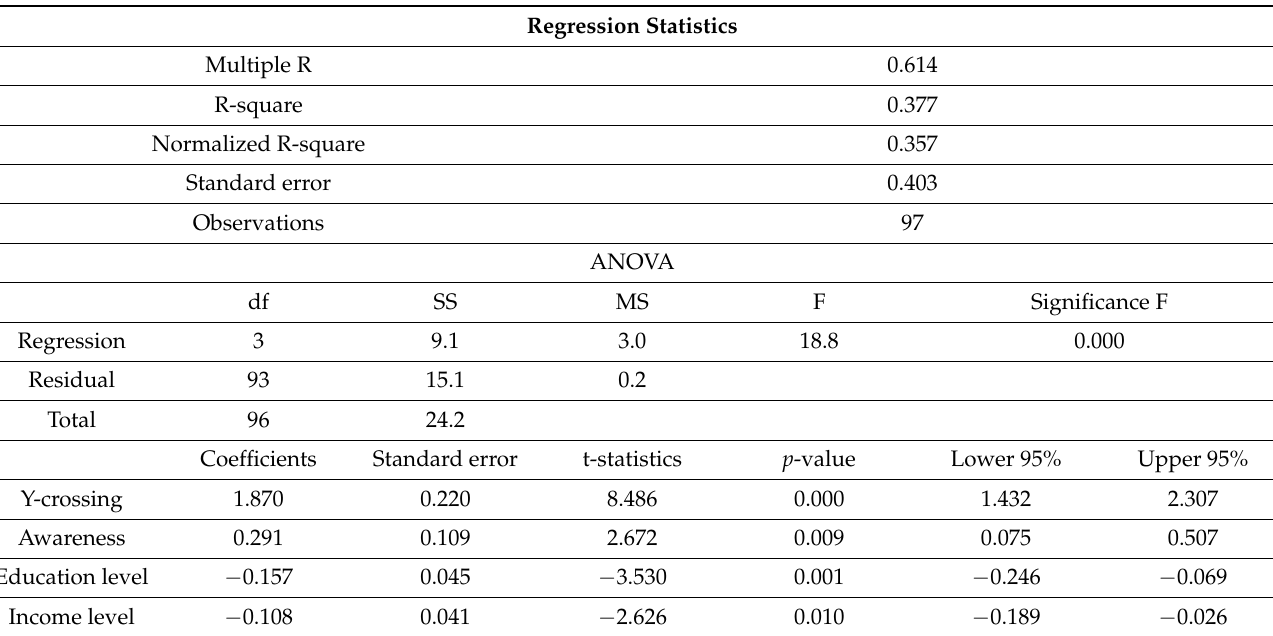
Table 2. Indicators of multivariate statistical analysis (performed by the authors, 2021). Regression